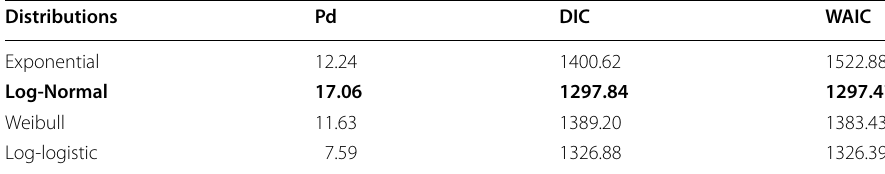
Bold values indicate better results than other filtering methods Source: JUMC, Jimma, Ethiopia; from first January 2016 to first January 2019